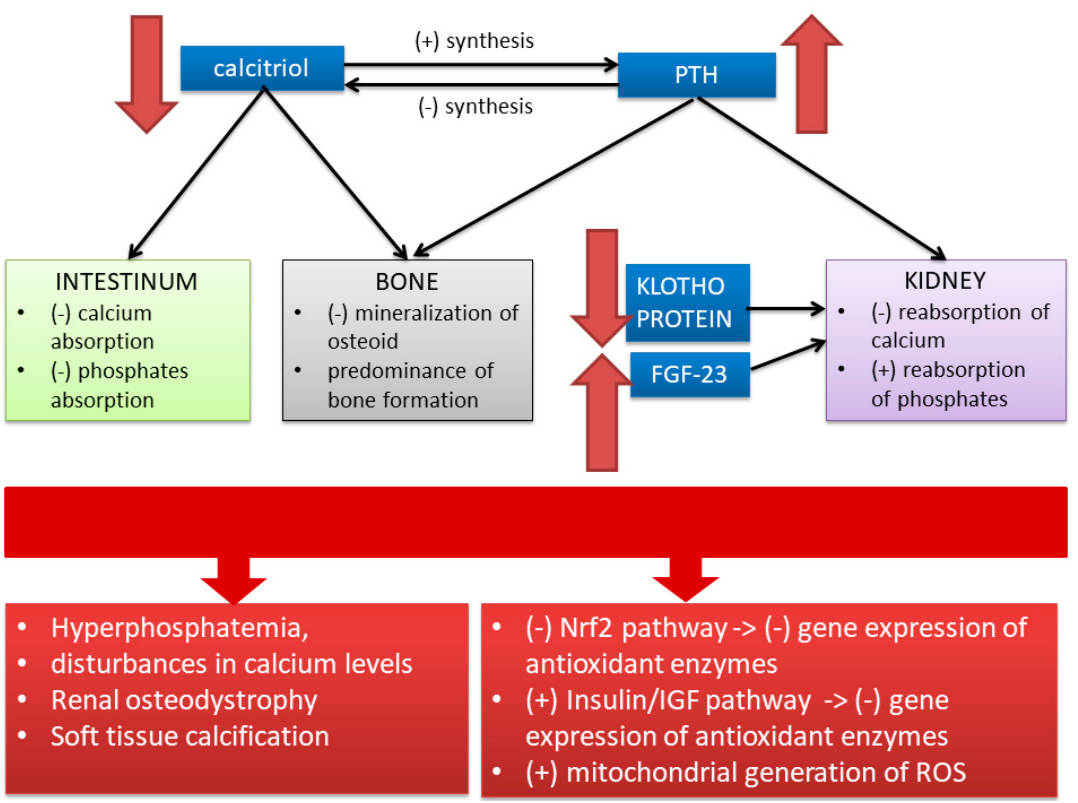
ff ect of oxidative stress on calcium and phosphate disorders in Figure 4. The effect of oxidative stress on calcium and phosphate disorders in CKD. Figure 4. The e